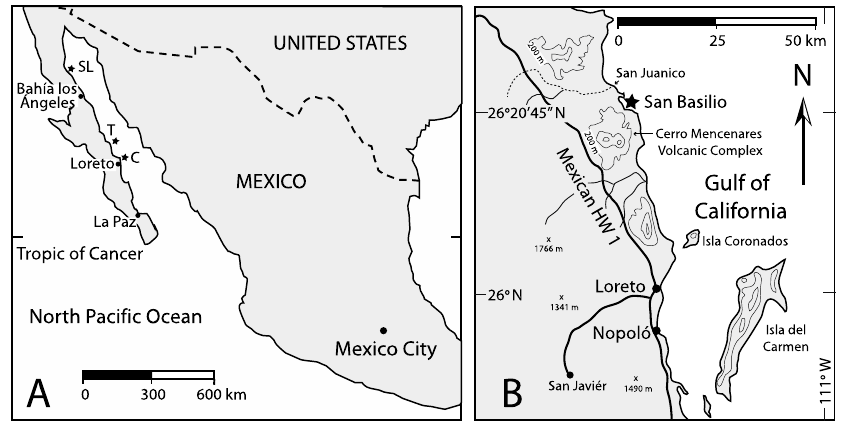
Figure 1. Regional and local maps: ( A ) Mexico and the Baja California peninsula, showing sites where volcano superstructures are preserved as islands in the Gulf of California (SL = Isla San Luis; T = Isla Tortuga; C = Isla Coronados), ( B ) Eastern shore of Baja California Sur between Nopoló and San Juanico, showing the location of San Basilo (star). Geosciences 2019 , 9 FOR PEER REVIEW